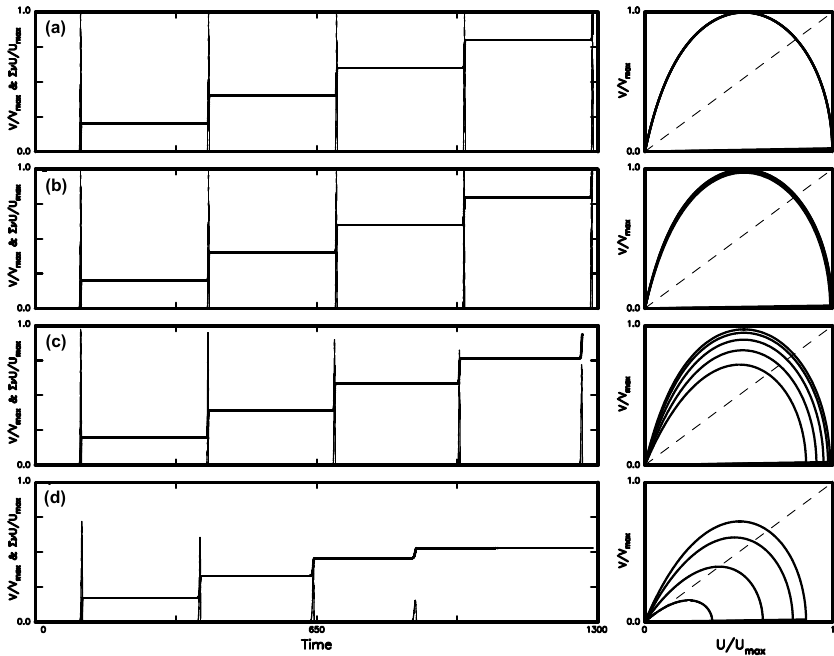
Figure 8. The time variations in V/V max (thin solid line) and cumulative slip (cid:54)U/U max (solid line) and the phase portrait of V/V max versus U/U max (solid line) for four values of C : (a) for C = 0.0001; (b) for C = 0.001; (c) for C = 0.01; and (d) for C = 0.05 when U co = 0.1 and η = 0.